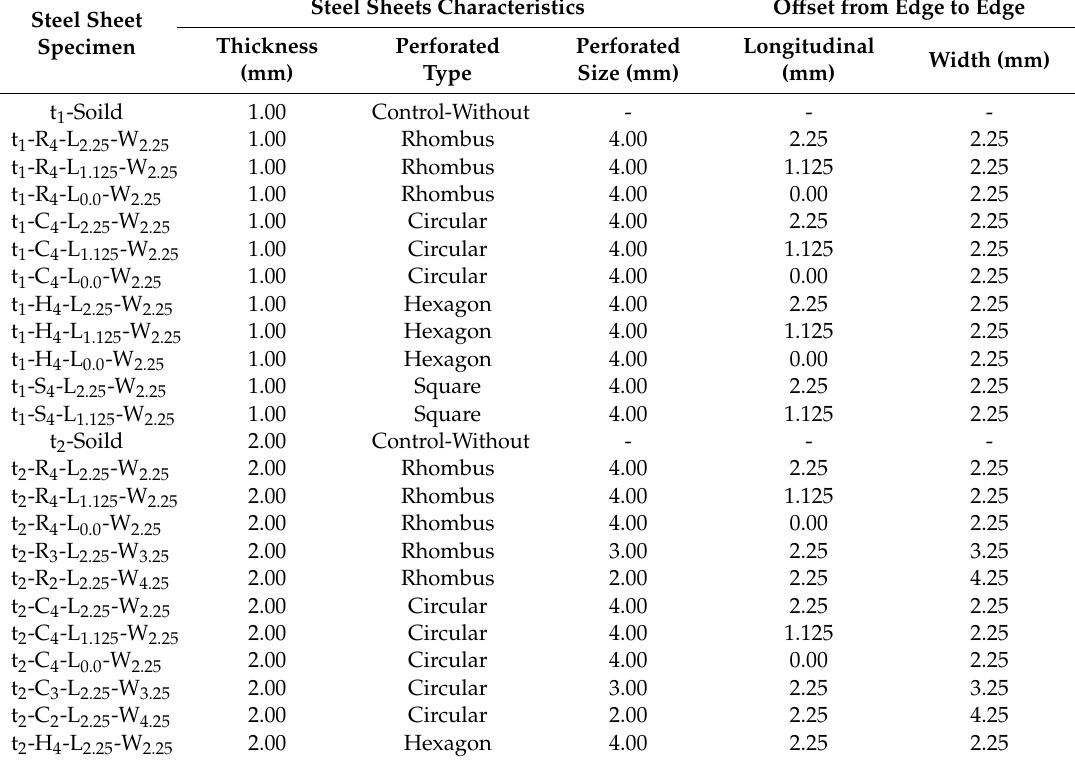
Figure 4. Geometrical details, perforated shapes and sizes of steel sheets were considered. Table 1. Summary of perforated steel sheets assessed in the current study using FE modeling.